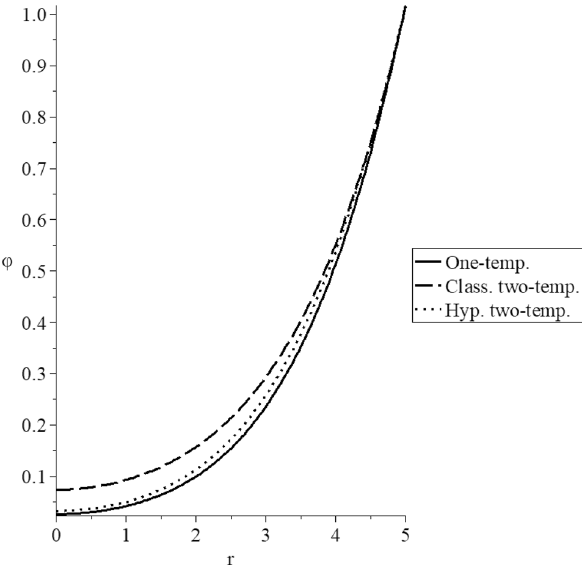
Figure 3. The conductive temperature increment distribution for different models.